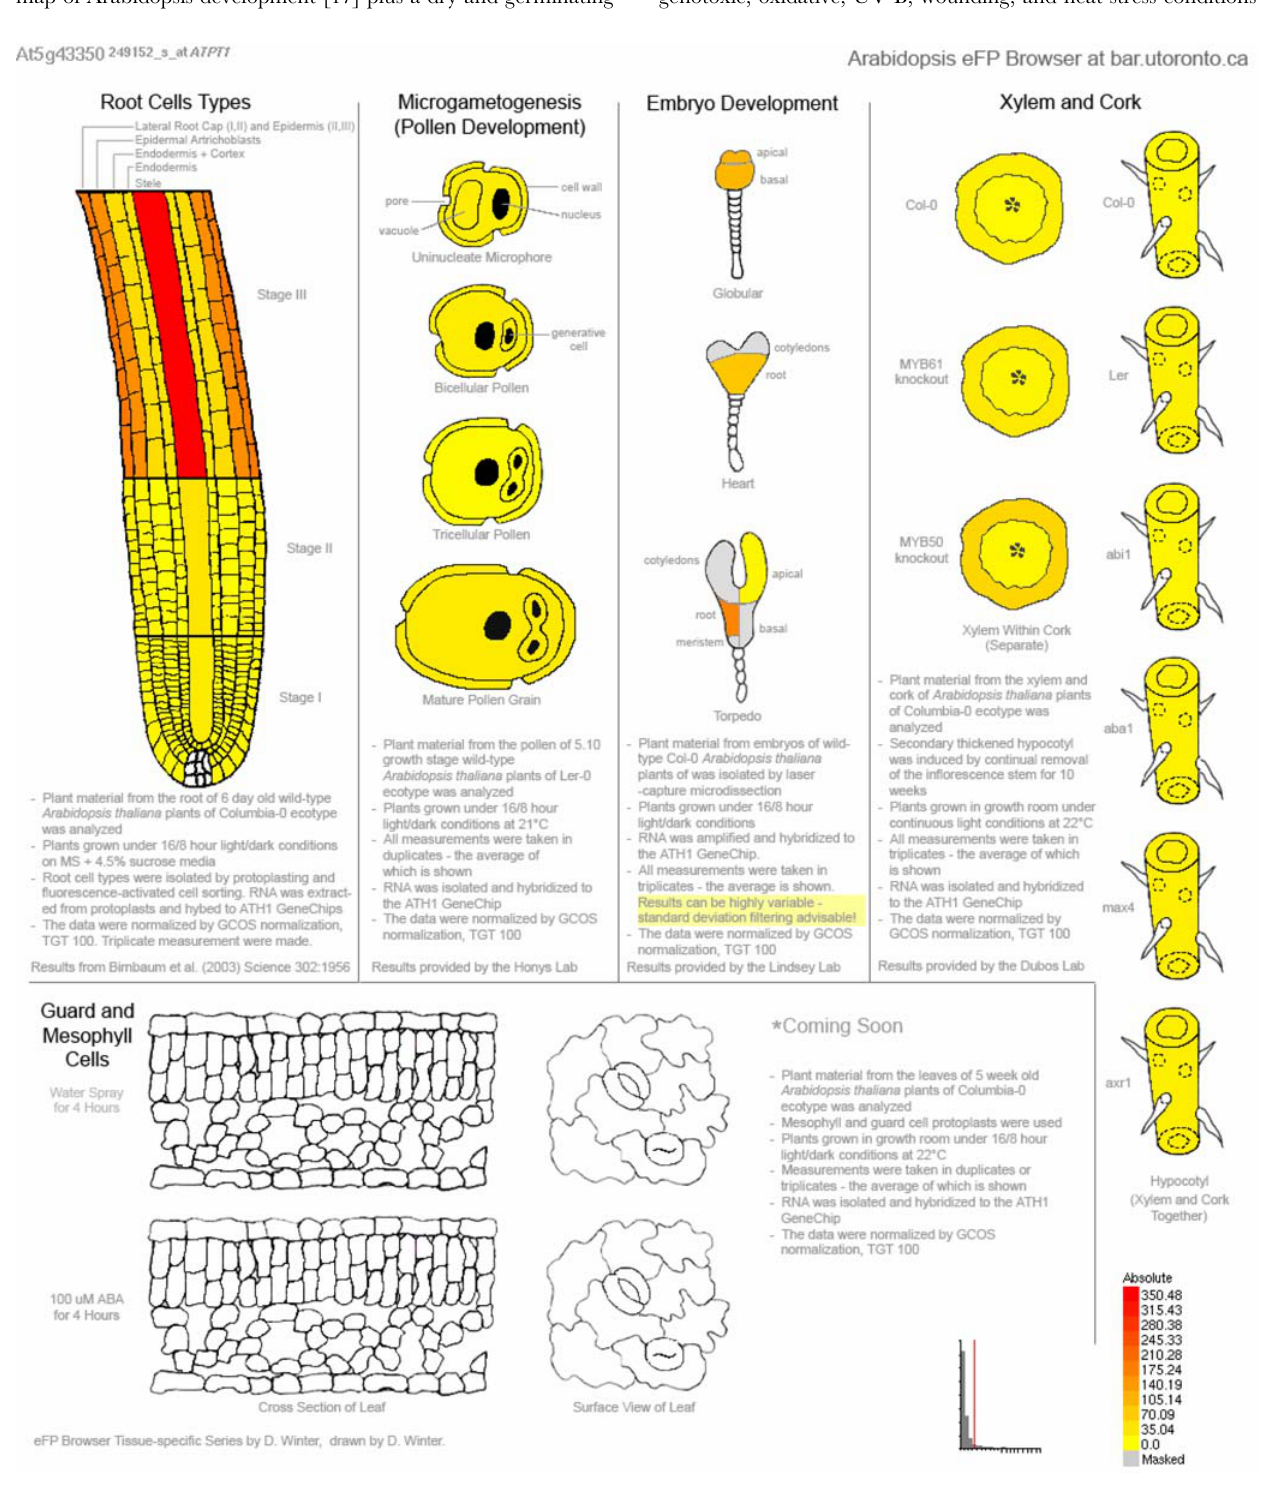
Figure 5. Tissue-specific expression patterns for At5g43350, AtPT1/Pht1;1. This gene encodes an inorganic phosphate transporter known to be strongly expressed in the roots. Tissues where values from replicate samples exhibit a high standard deviation are coloured grey – the standard deviation filtering feature of the Arabidopsis eFP Browser was activated during output generation.